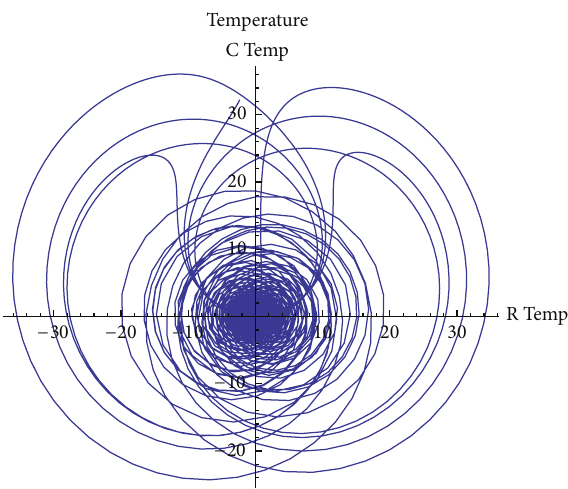
Figure3:Achaoticglobalattractorofrealandcomplextemperature for 𝜀 = 10, 𝐵 = 50, ] = 0 .